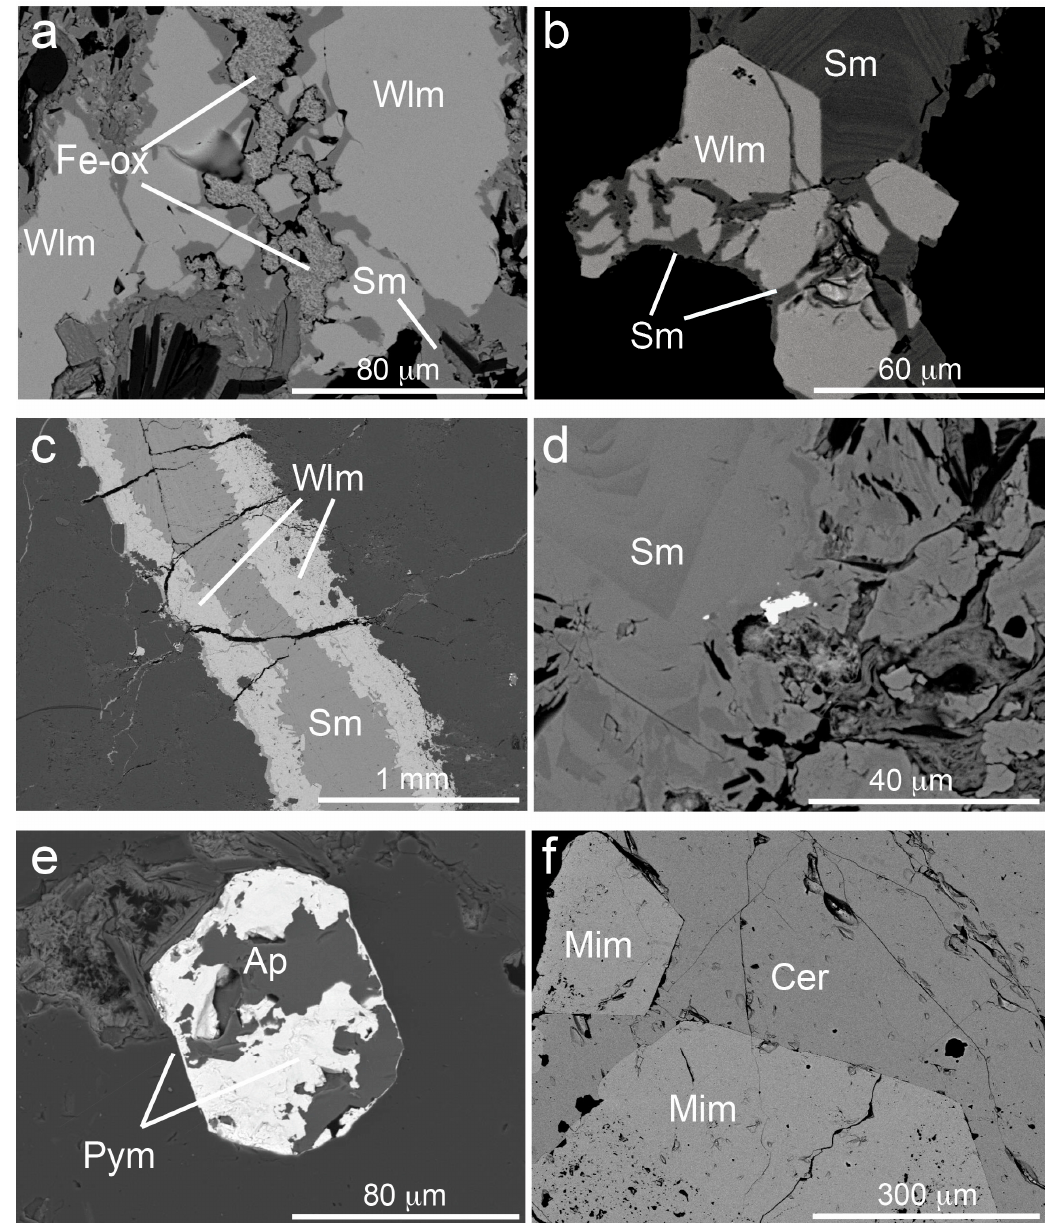
Figure 9. Backscatter electron SEM micrographs. Mineral chemistry was determined through EDS. ( a ) KDD 143-22. Willemite altered and partially replaced by smithsonite and Fe-oxy-hydroxides; ( b ) KDD 143-23. Idiomorphic willemite crystals, vein-crossed and partially altered to zoned smithsonite; ( c ) KDD 143-16. Thin willemite vein, internally filled with smithsonite; ( d ) KDD 143-16. Zoned crystals of smithsonite; in the center small galena remnant; ( e ) KDD 143-26. Fluorapatite crystal patchily replaced (Pb → Ca and Cl → F) by pyromorphite; ( f ) KDD 143-23. Idiomorphic mimetite crystals embedded in cerussite. Ap = fluorapatite; Cer = cerussite; Fe-ox = Fe-oxy-hydroxides; Mim = mimetite; Sm = smithsonite; Wlm = willemite.